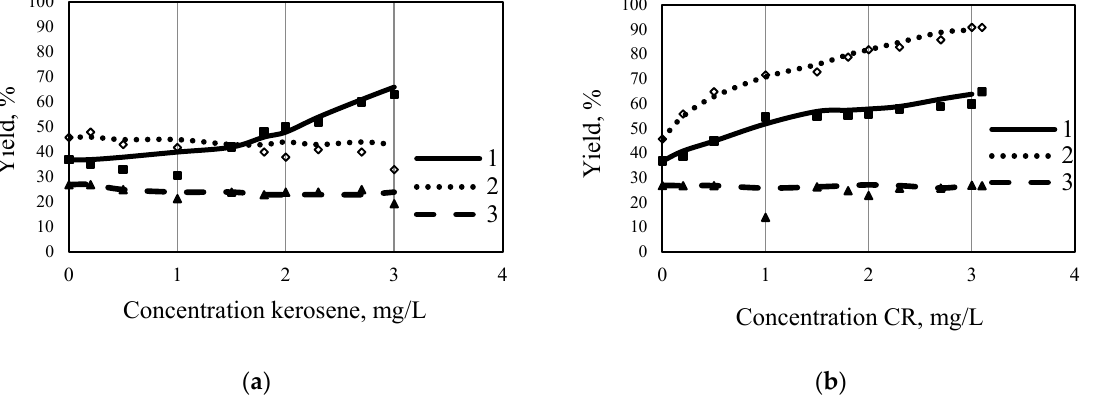
Figure 4. Floatability curves of molybdenite (1), chalcopyrite (2) and pyrite (3) via kerosene ( a ) and CR ( b ) concentration.